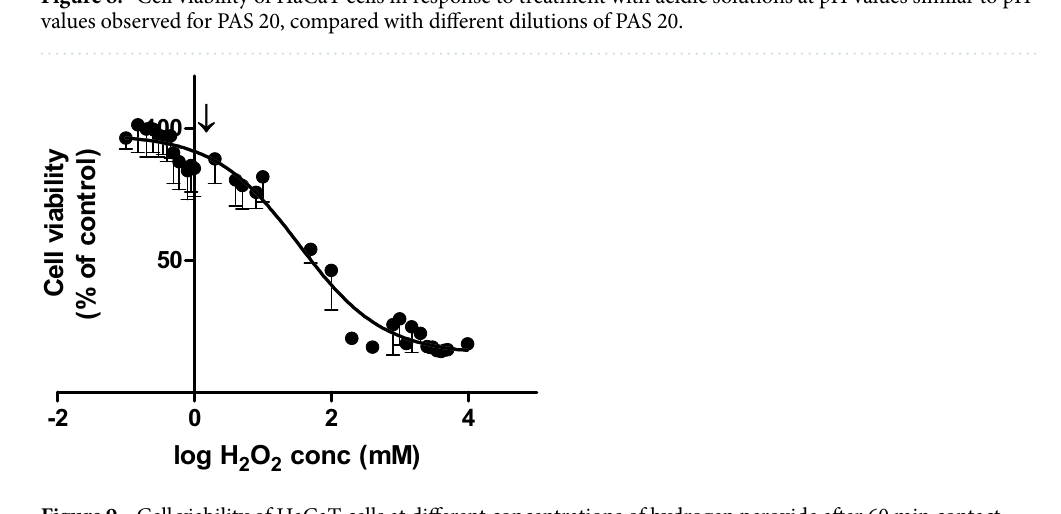
Figure 9. Cell viability of HaCaT cells at different concentrations of hydrogen peroxide after 60 min contact time, arrow indicates H 2 O 2 concentration in